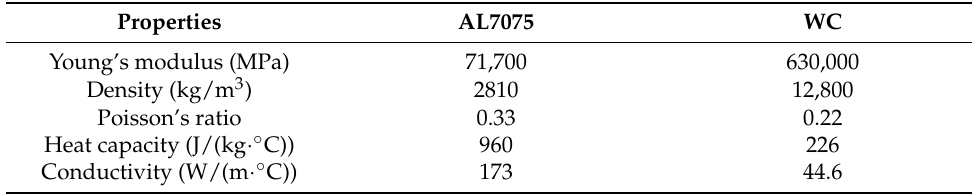
Table 2. Thermo-mechanical properties of AL7075 and